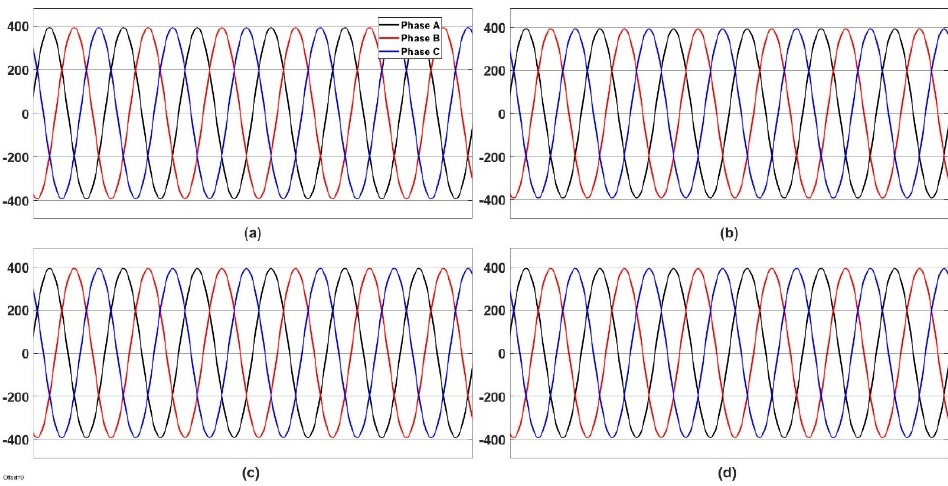
Figure 13. Three-phase pcc voltages in the case of ( a ) 2L- αβ , ( b ) 3L- αβ , ( c ) 2L-dq and ( d ) 3L-dq.